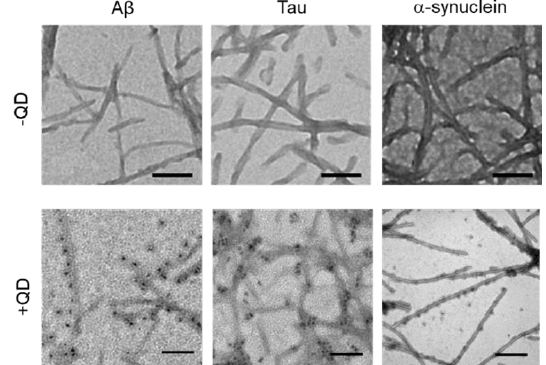
Figure 3. Transmission electron microscopy (TEM) observations of various amyloid fibrils of 30- µ M A β , 10- µ M tau, and 10- µ M α -synuclein with quantum dot (QD) nanoprobes. Top panel, low-magnitude image of each protein without QDs. Bottom panel, high-magnitude images of each protein with 30-nM QDs. Note that QD nanoprobes, observed as black dots, bind to fibrils in each protein. Bars, 100